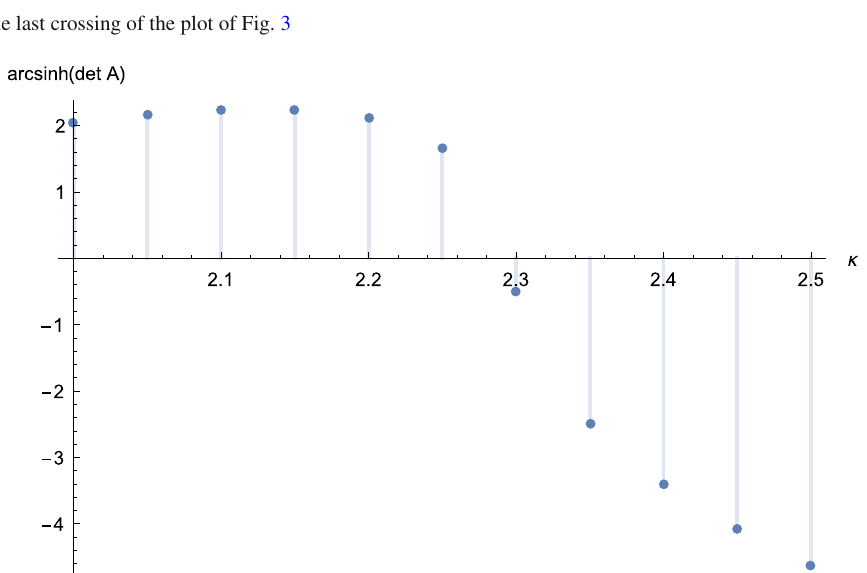
Fig. 4 A zoom on the last crossing of the plot of Fig. 3